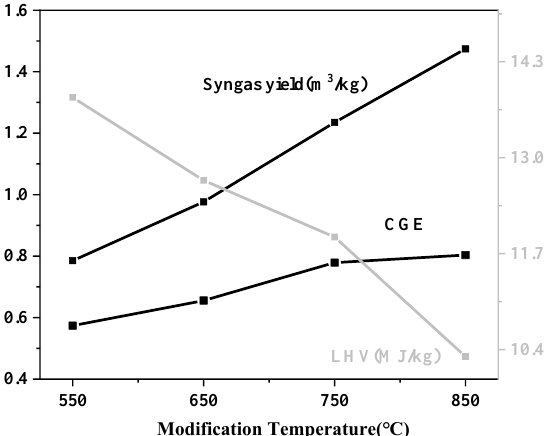
Figure 9. Effect of modification temperature on gas distribution for modified syngas.